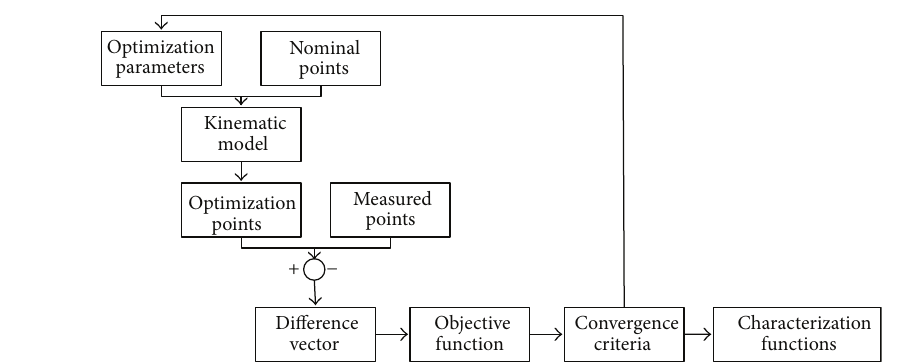
Figure 9: Errors characterization